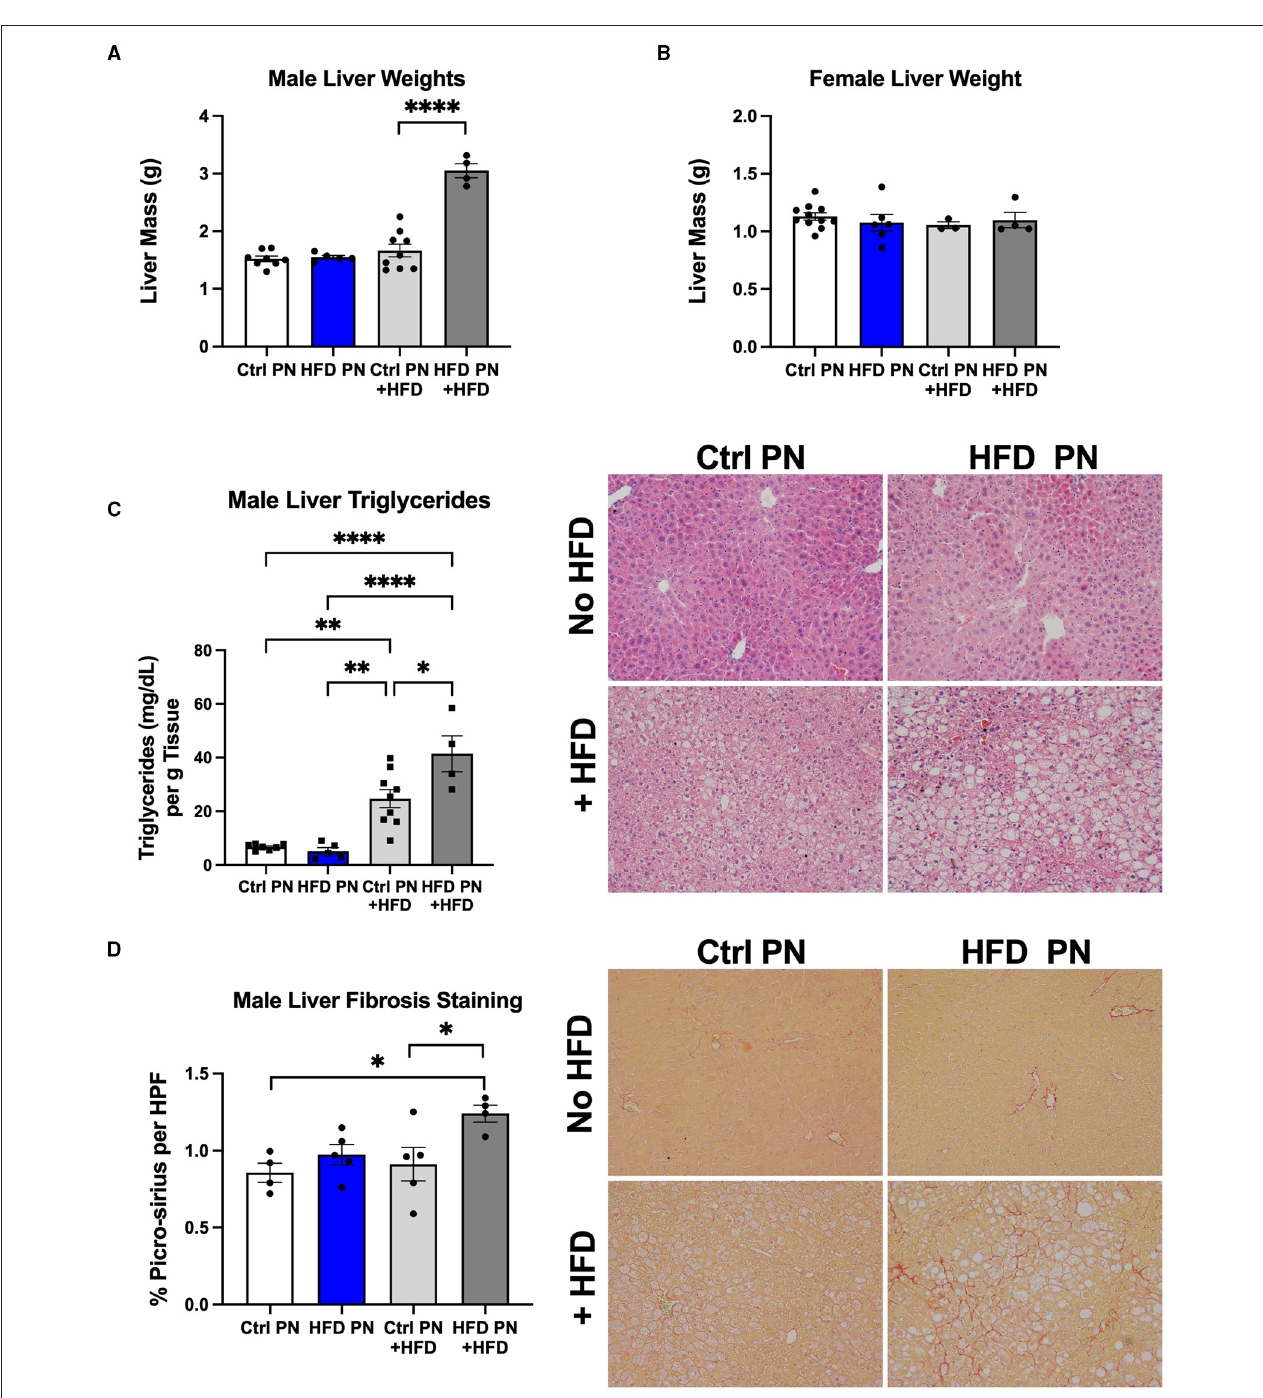
FIGURE 4 | Offspring liver morphology and metabolic characteristics. Liver weights at necropsy (6 months of age) in male (A) and female (B) offspring during both ND feeding (no HFD) and HFD rechallenge. ND results are white for Ctrl PN and blue for HFD PN. HFD rechallenge results are in light gray for Ctrl PN + HFD and dark gray for HFD PN + HFD (C) . Liver triglyceride quantification and representative histology by hematoxylin and eosin (H&E) staining to visualize fat accumulation as open spaces. (D) Liver fibrosis quantification by picro-sirius staining with representative images showing red-stained collagen fibers. Ctrl, control; HFD, high-fat diet; PN, post-natal; HPF, high-power field. * p < 0.05, ** p < 0.01, **** p < 0.0001.